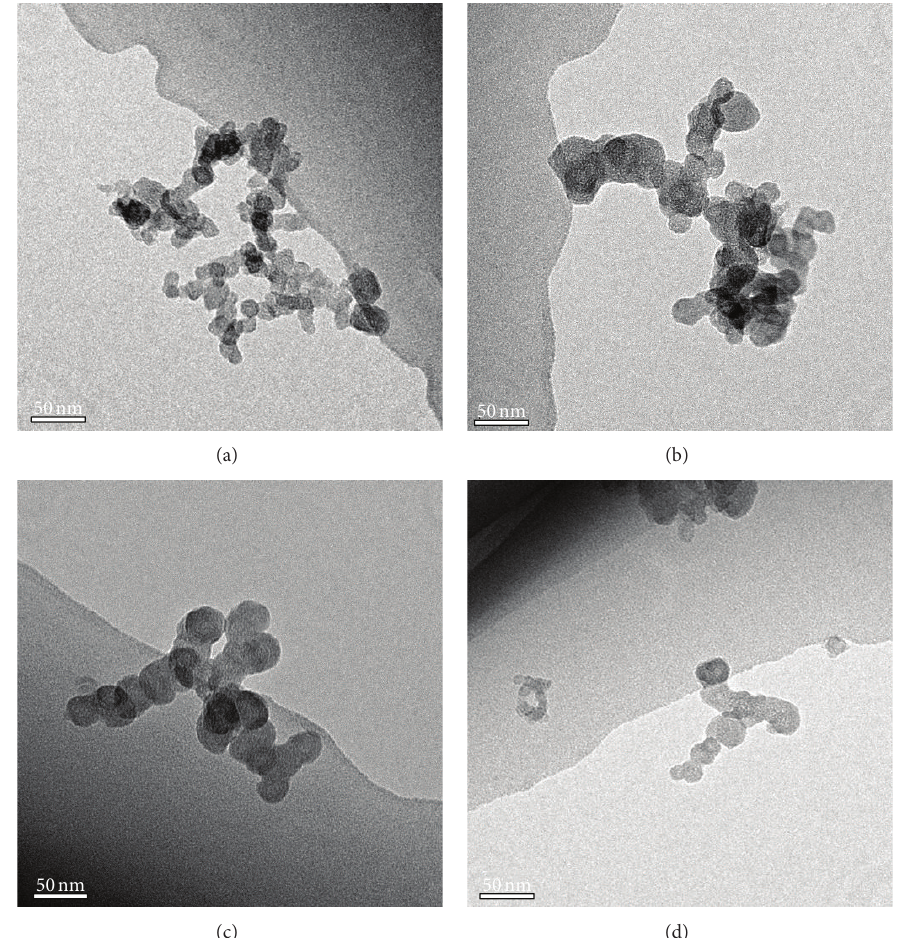
Figure 4: TEM photographs of diesel particulates sampled at 2000 rpm/25% load when fueled with pure